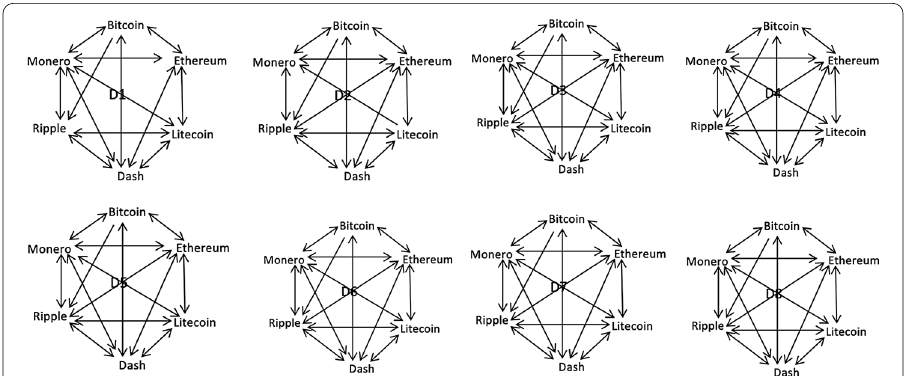
Fig. 4 Non‑linear causality at different MODWT levels (from D1 to D8). Notes : The arrows in the solid lines indicate the causality direction between each cryptocurrency market pair. The nonlinear causality between BTC and Litecoin is insignificant for this reason we did not have